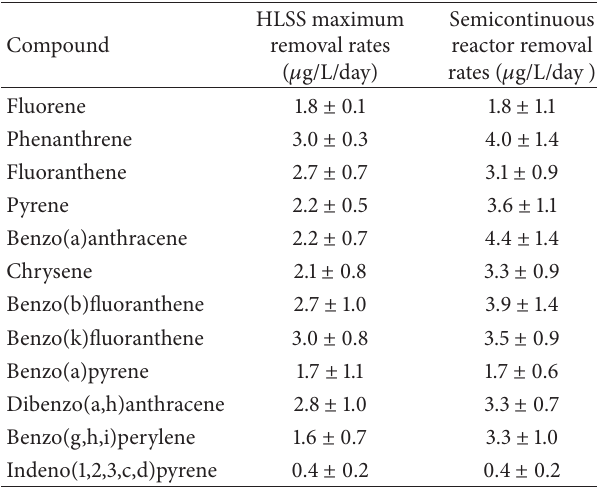
Table 2: 𝜇 P maximum removal rates in biotic and spiked HLSS reactors(seriesA).Comparisonwiththe 𝜇 Premovalratescalculated in the semicontinuous reactor at steady states [7].